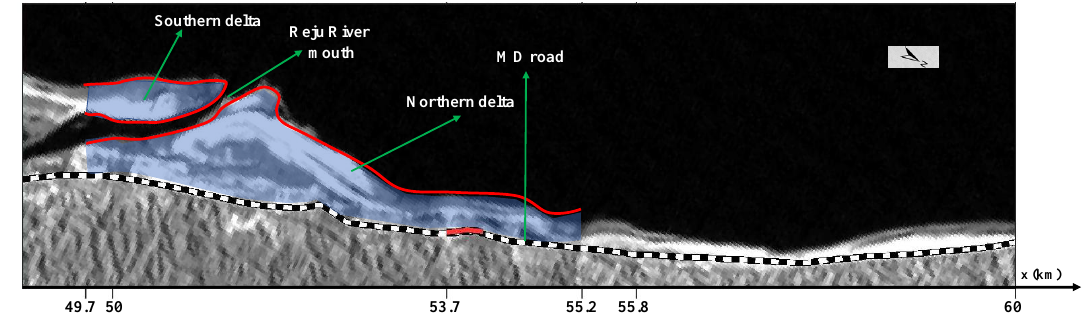
Figure 9. Configuration of the domain for delta area calculation.